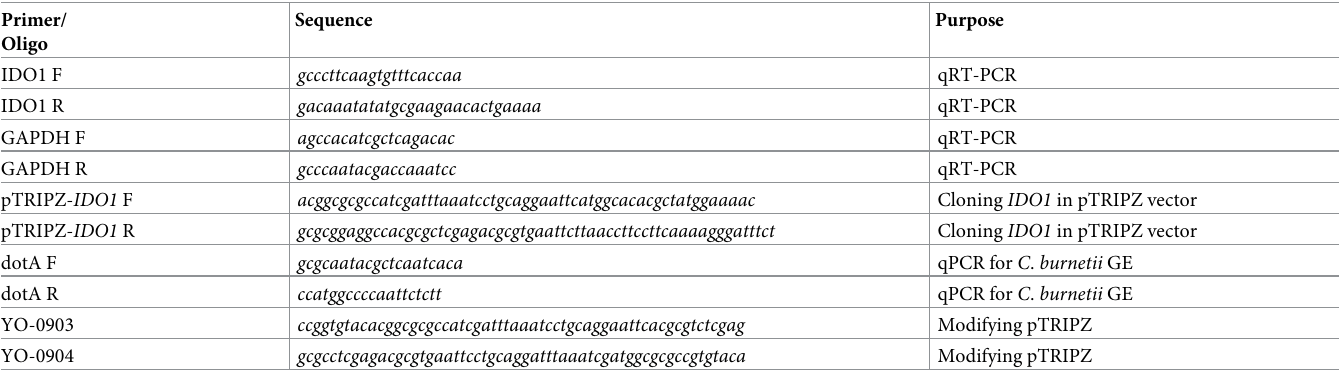
Table 4. Primers and oligos used in this